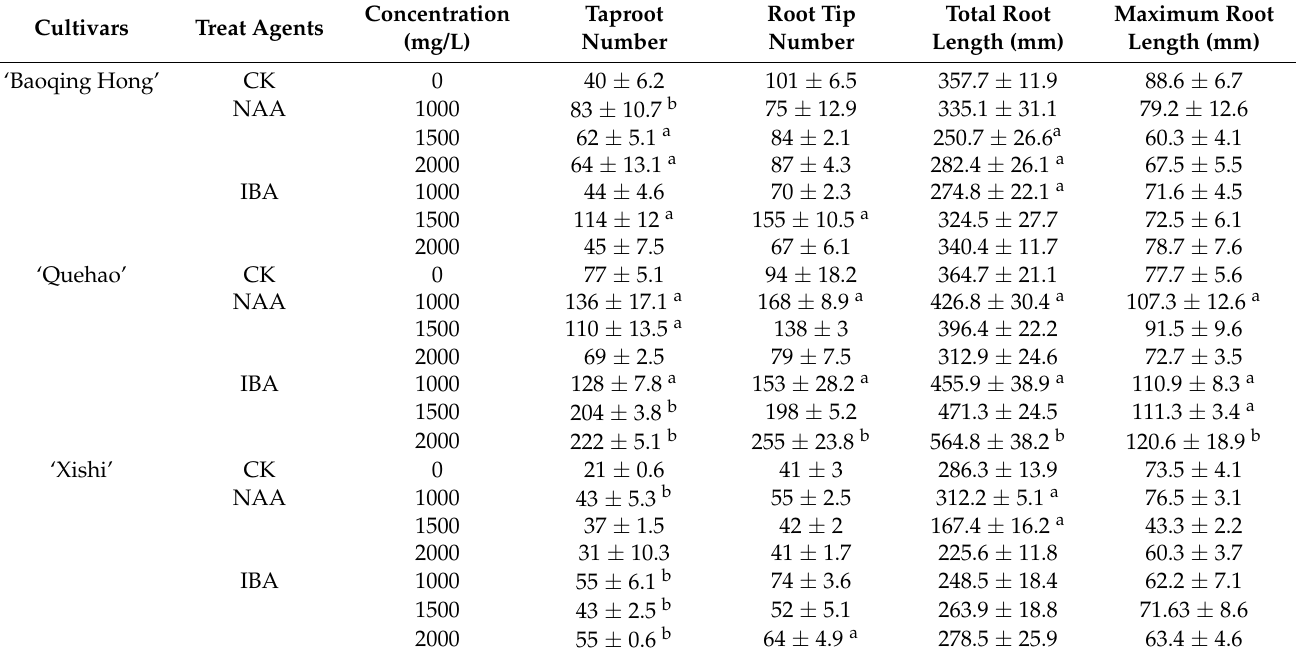
Table 2. Air-layered root traits of the tree peony varieties under the different